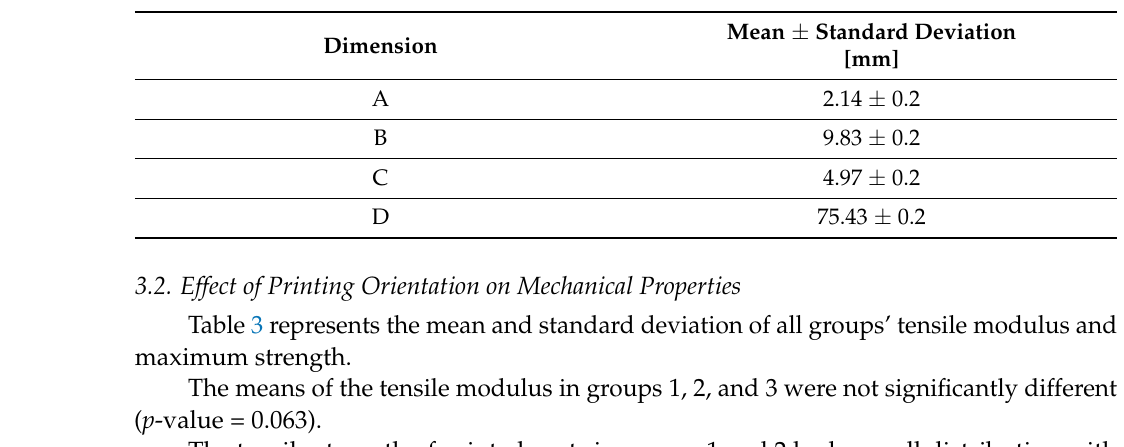
Table 2. Dimensional accuracy in group 1 considering four different dimensions.